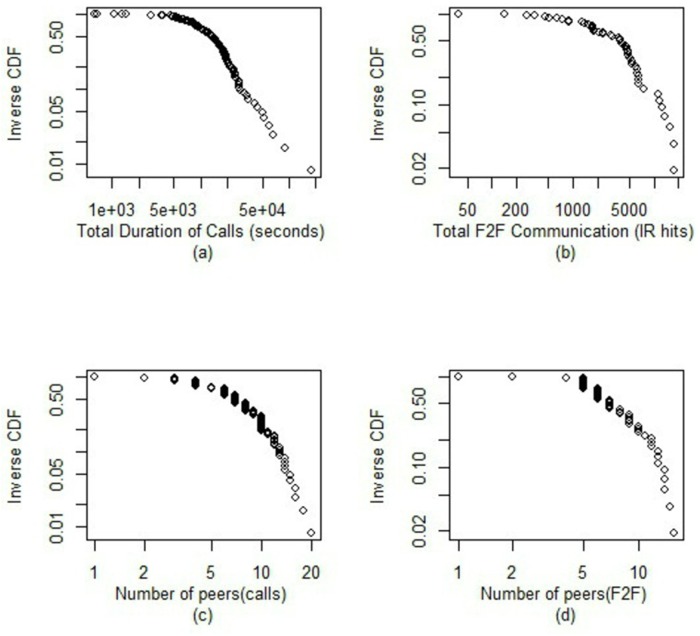
(a) Distribution of total time spent on phone calls by participants (b) Distribution of total time spent communicating through face-to-face interaction (c) Distribution of personal network sizes via mobile phones calls (d) Distribution of personal network sizes via face-to-face interaction.Generally, few individuals have very long phone calls or face-to-face interactions. Also, few individuals have a high number of social contacts.